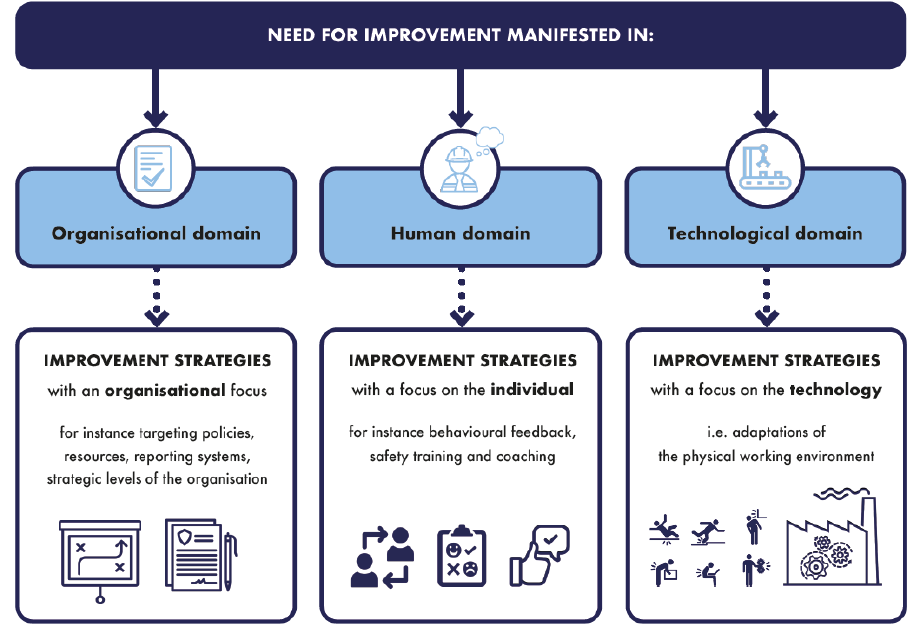
Figure 9. Focus of the safety culture improvement strategies.